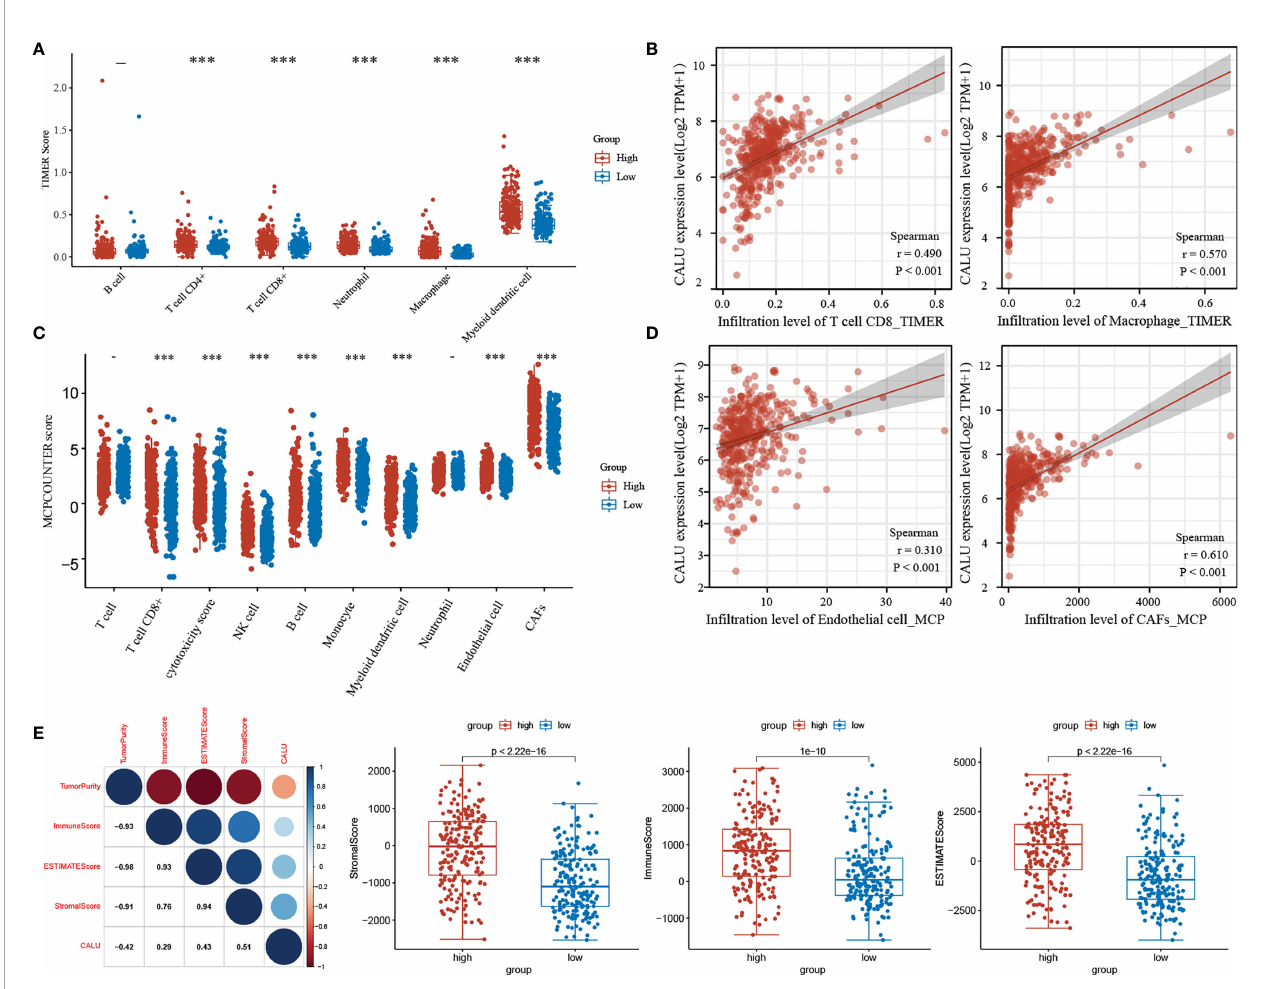
FIGURE 5 | The dual regulatory function of CALU on TME. (A – D) The TIMER and MCP-COUNTER algorithms indicated the signi fi cant correlation of CALU with CD8 T cells (p<0.001, R=0.490), macrophages(p<0.001, R=0.570), endothelial cells (p<0.001, R=0.310) and CAFs (p<0.001, R=0.610). (E) CALU expression level positively correlated with the stromal (p<0.001, R=0.510), immune (p<0.001, R=0.290) and ESTIMATE scores (p<0.001, R=0.430) and negatively associated with tumor purity (p<0.001, R=-0.420).